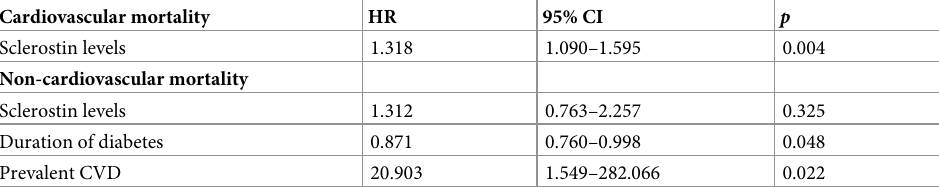
Table 2. Factors independently associated with mortality in the entire cohort, using a Cox proportional hazards model. Cardiovascular mortality HR 95%